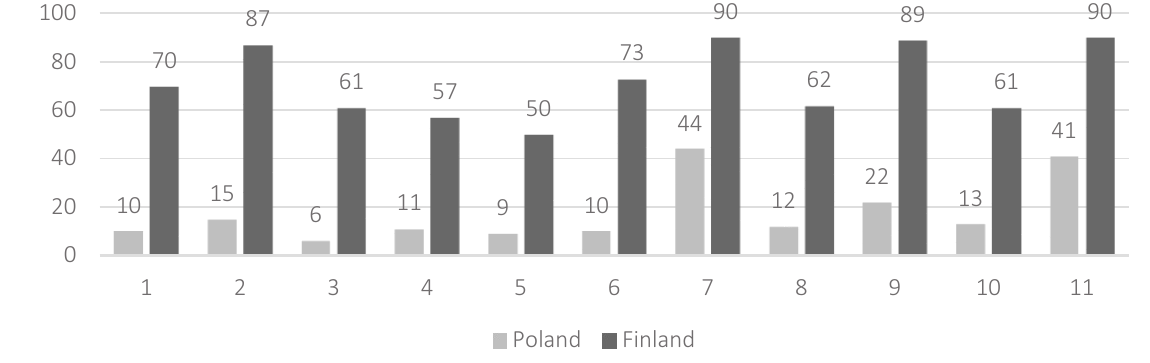
Figure 3. Percentage of enterprises using cloud computing services in 2018 by type of business activity